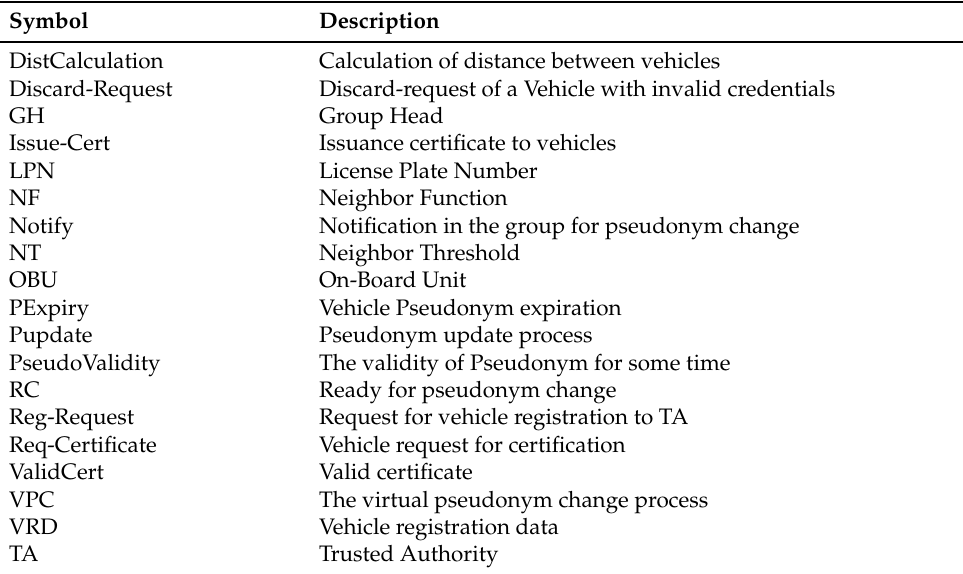
Table 2. Symbols used in HLPN for DGVP scheme.